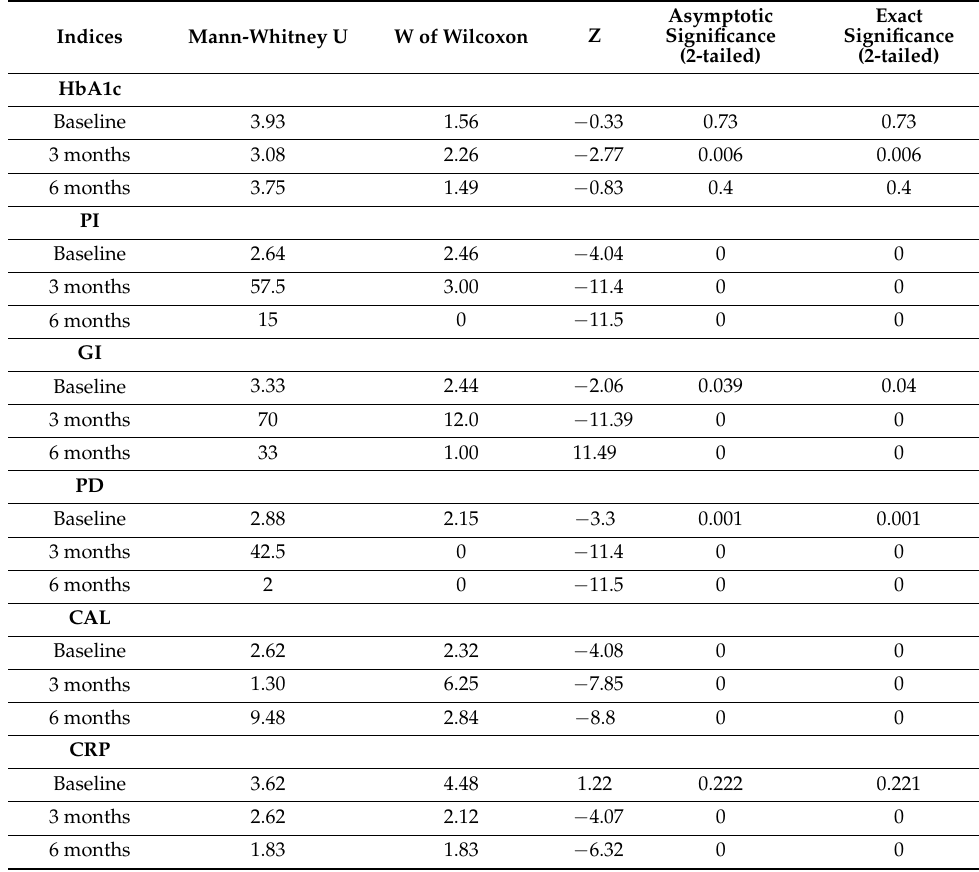
Table 6. Comparison between groups at each time